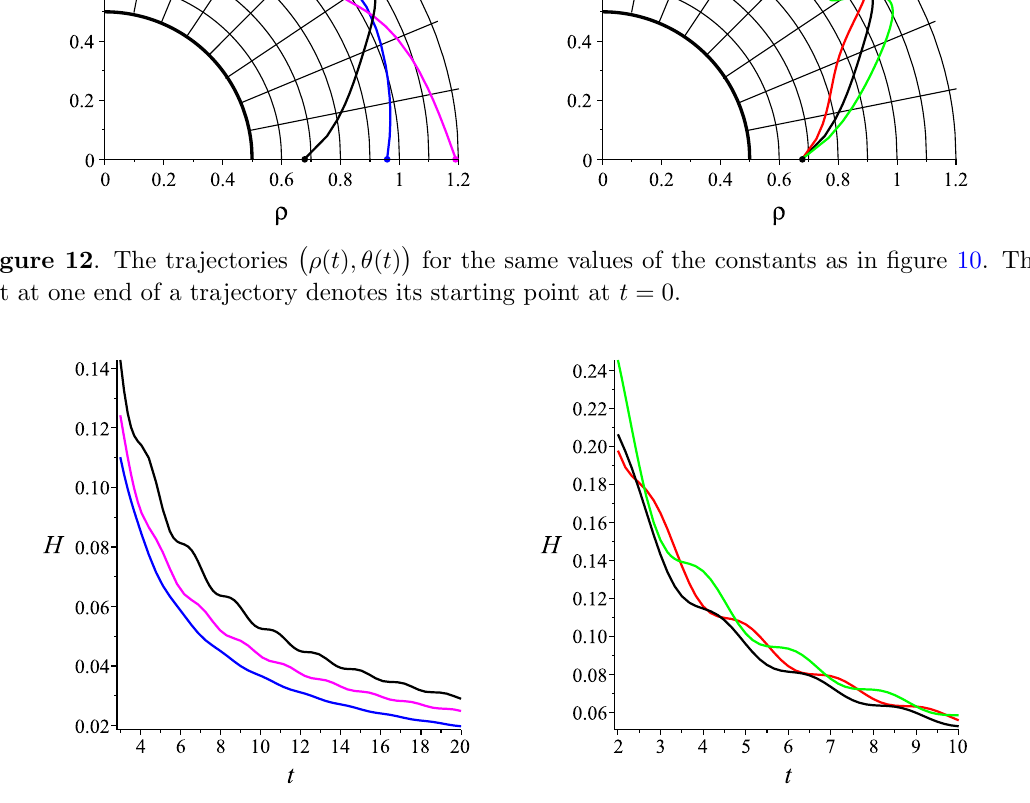
Figure 13 . The Hubble parameters H ( t ) for the same values of the constants as in (cid:12)gure 10.